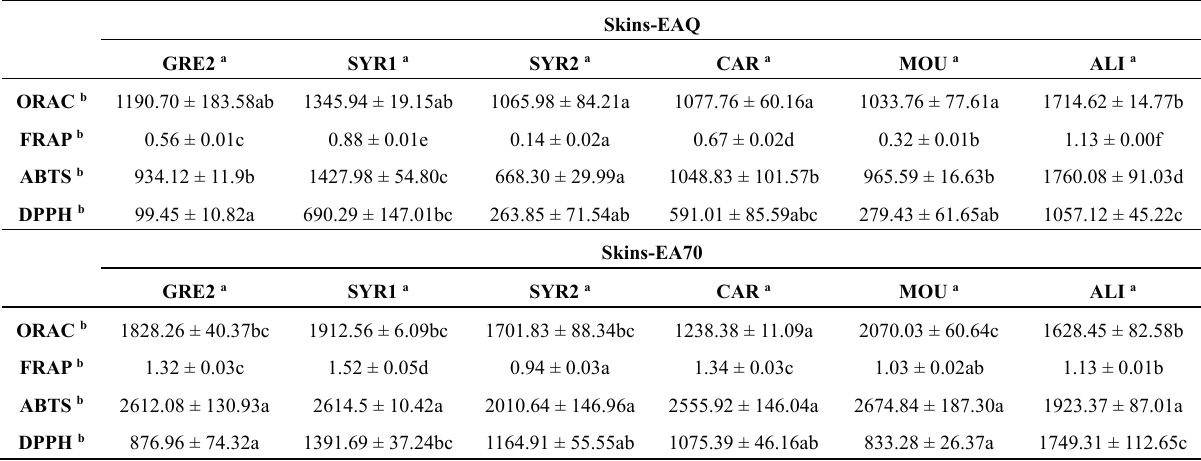
Table 6. Antioxidant activity characterisation in EAQ and EA70 grape pomace skin extracts.